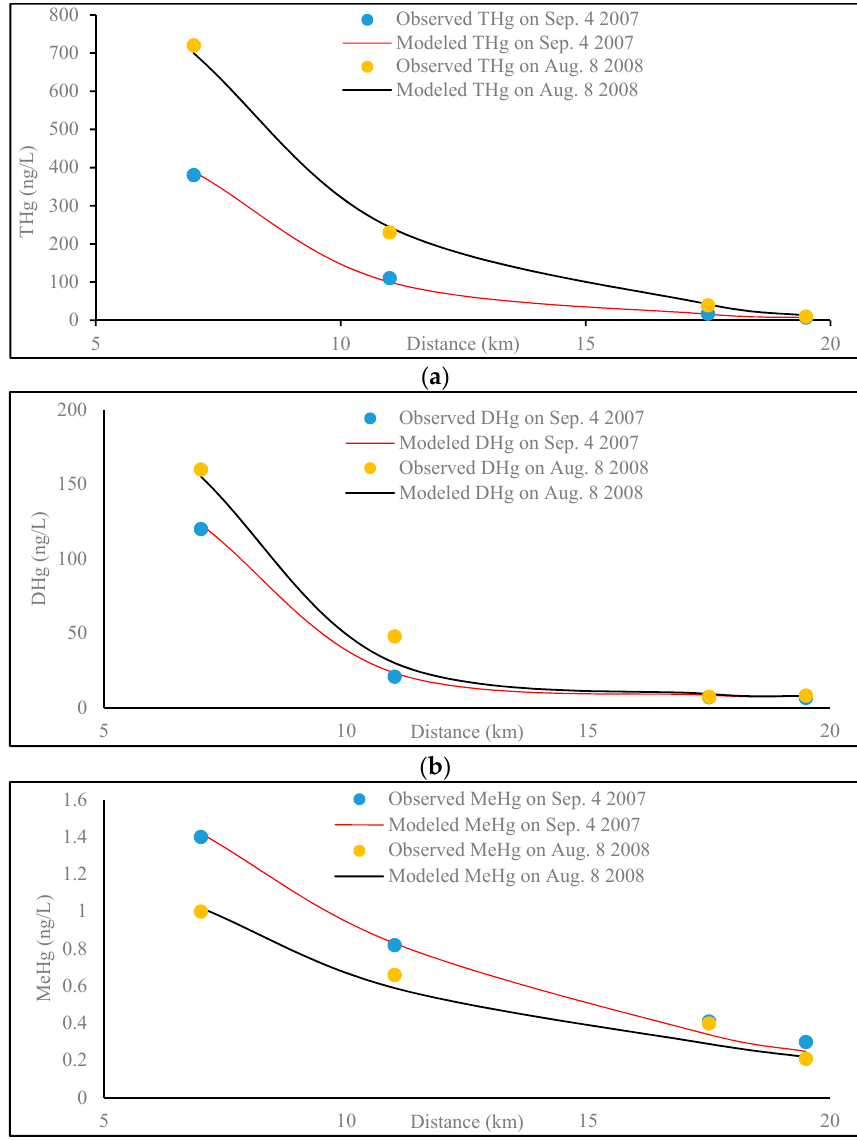
Figure 15. Comparison of W2 modeled and observed Hg concentrations: ( a ) THg, ( b ) DHg, ( c ) MeHg.